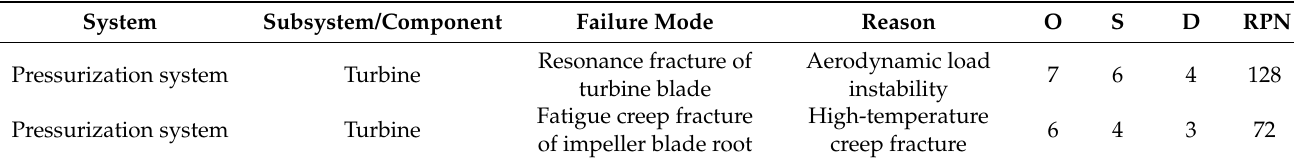
Table 11. The physical-level failures according to the